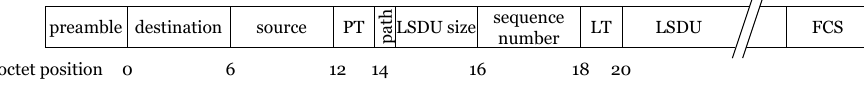
Figure 2. An illustration of the HSR frame